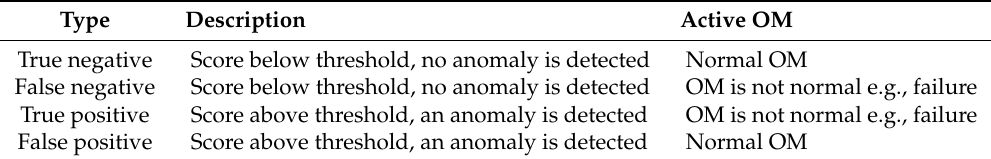
Table 3. Potential ground truth of